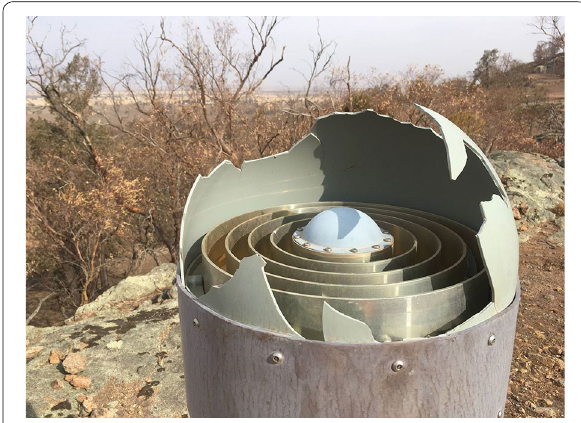
Fig. 5 Site WWLG in New South Wales, Australia. The antenna radome was damaged at the end of year 2018. Photo courtesy of Simon